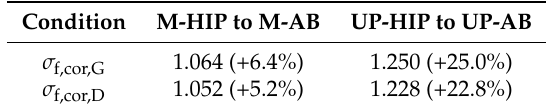
Table 8. Impact of the microstructure on the fatigue strength in residual stress free